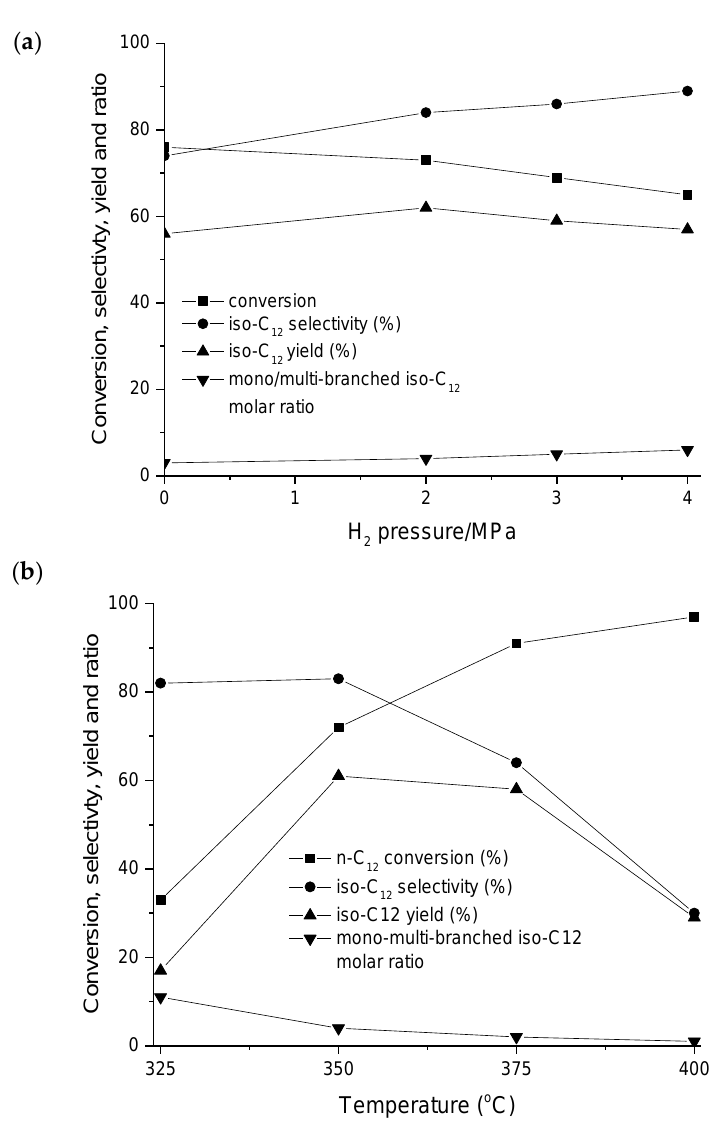
Figure 13. Conversion, selectivity, yield of isomer, and the ratio between mono/multibranched isomers in dodecane hydroisomerization over Ni x P y -SAPO-11 as a function of ( a ) hydrogen pressure and ( b ) H 2 /feed molar ratio [26]. Reproduced with permission from Tian et al., Fuel Process. Technol. ; published by Elsevier, 2014 .